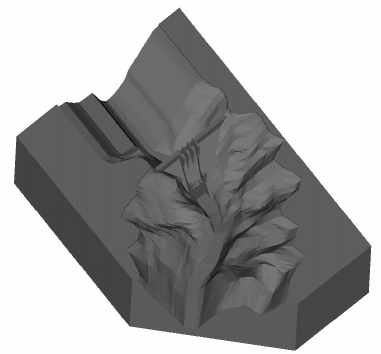
Figure 9. Geometrical model of the ShiZiYa reservoir system (design).